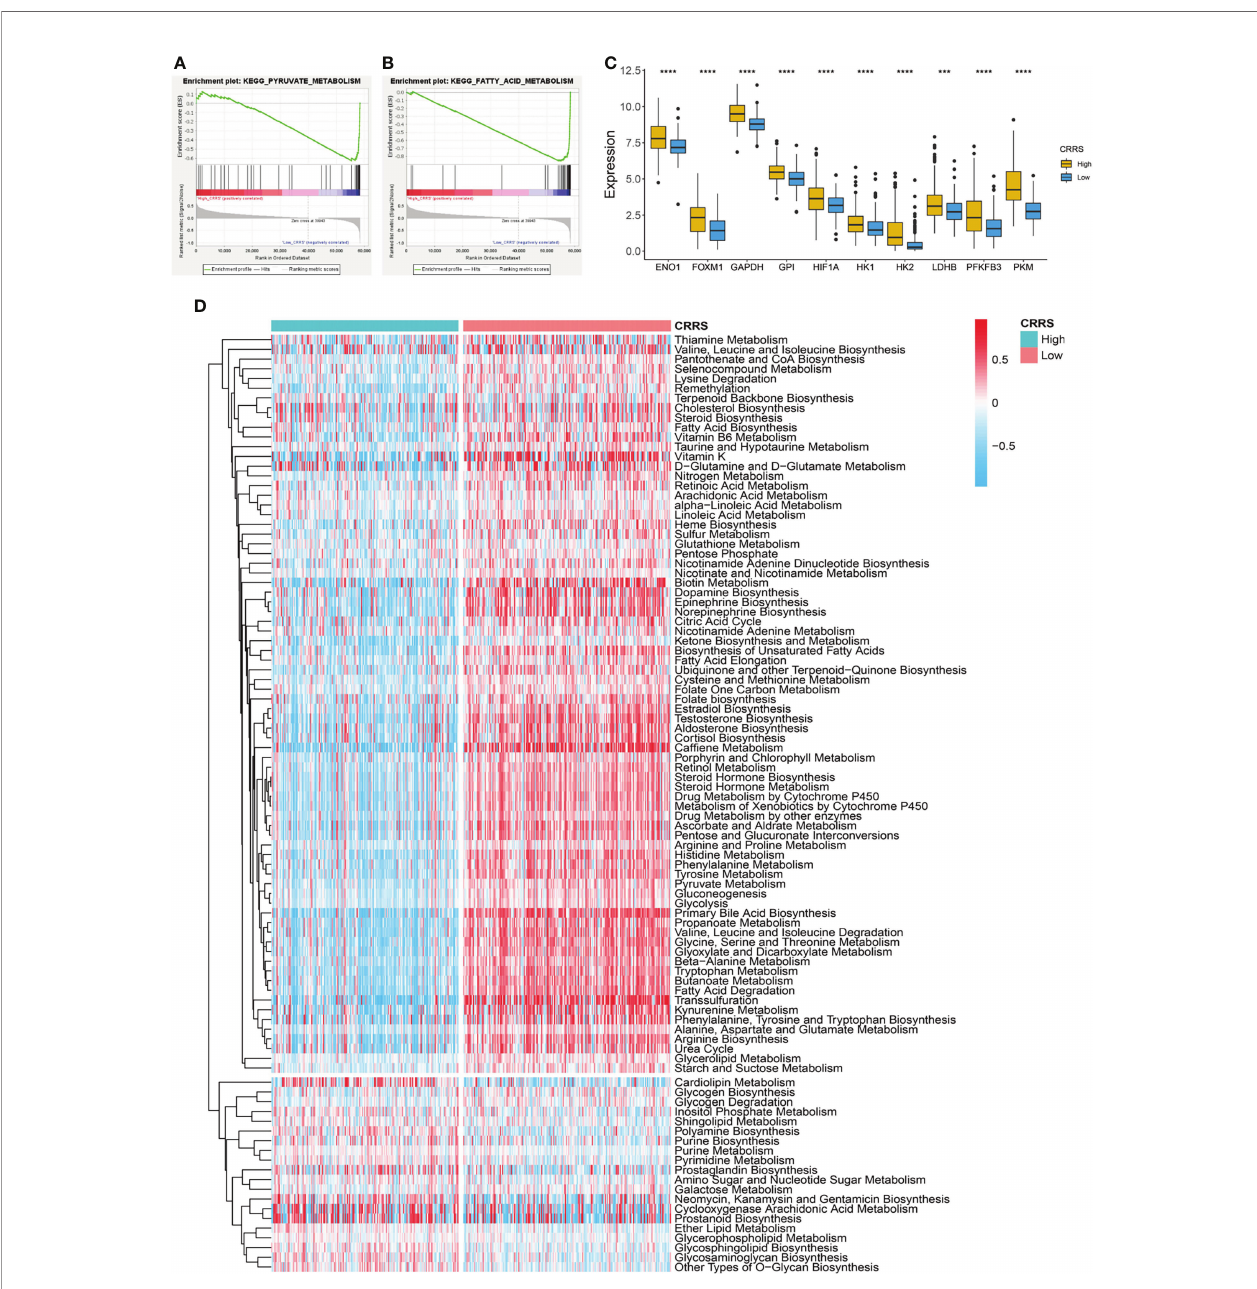
FIGURE 4 | Metabolic features of CRRS-based HCC groups. (A, B) GSEA of the low-CRRS group in TCGA-LIHC cohort. (C) Boxplot showing the expression of glycolysis-related genes in the HCC patients with low or high CRRS. Wilcoxon test was used for data analyses. (D) Heatmap of the enrichment score of metabolism- related pathways in the HCC patients from the low- or high-CRRS subgroups. The p values were shown as ****p <